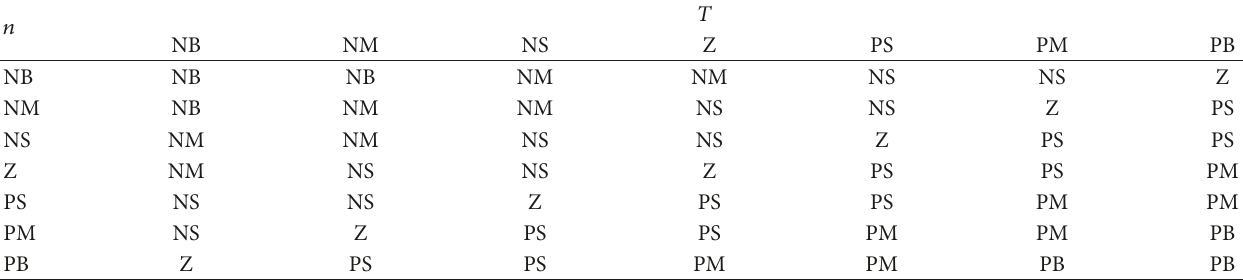
Table 1: Fuzzy control rule